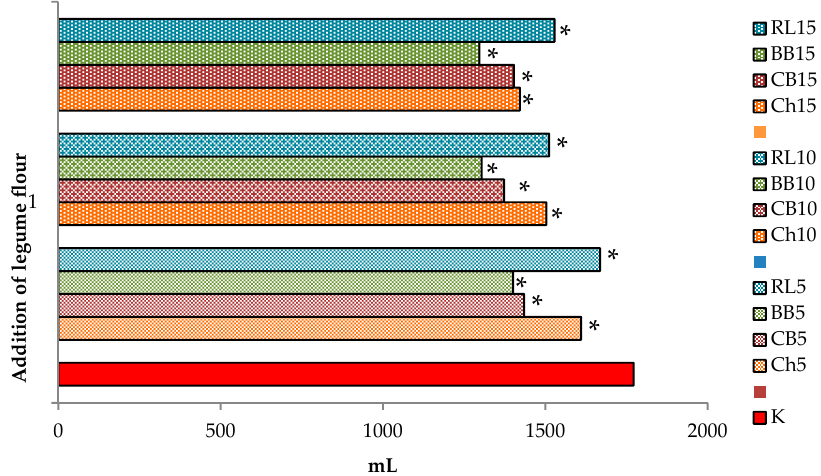
Figure 9. Bread volume of trial breads. Comparing breads with the addition of 5%, 10% and 15% of legume flour. * values are significantly different ( p < 0.05) compared to control. K = WF(50) + RF(50); Ch5 = WF(50) + RF(45) + ChF(5); Ch10 = WF(50) + RF(40) + ChF(10); Ch15 = WF(50) + RF(35) + ChF(15); CB5 = WF(50) + RF(45) + CBF(5); CB10 = WF(50) + RF(40) + CBF(10); CB15 = WF(50) + RF(35) + CBF(15); BB5 = WF(50) + RF(45) + BBF(5); BB10 = WF(50) + RF(40) + BBF(10); BB15 = WF(50) + RF(35) + BBF(15); RL5 = WF(50) + RF(45) + RLF(5); RL10 = WF(50) + RF(40) + RLF(10); RL15 = WF(50) + RF(35) + RLF(15).